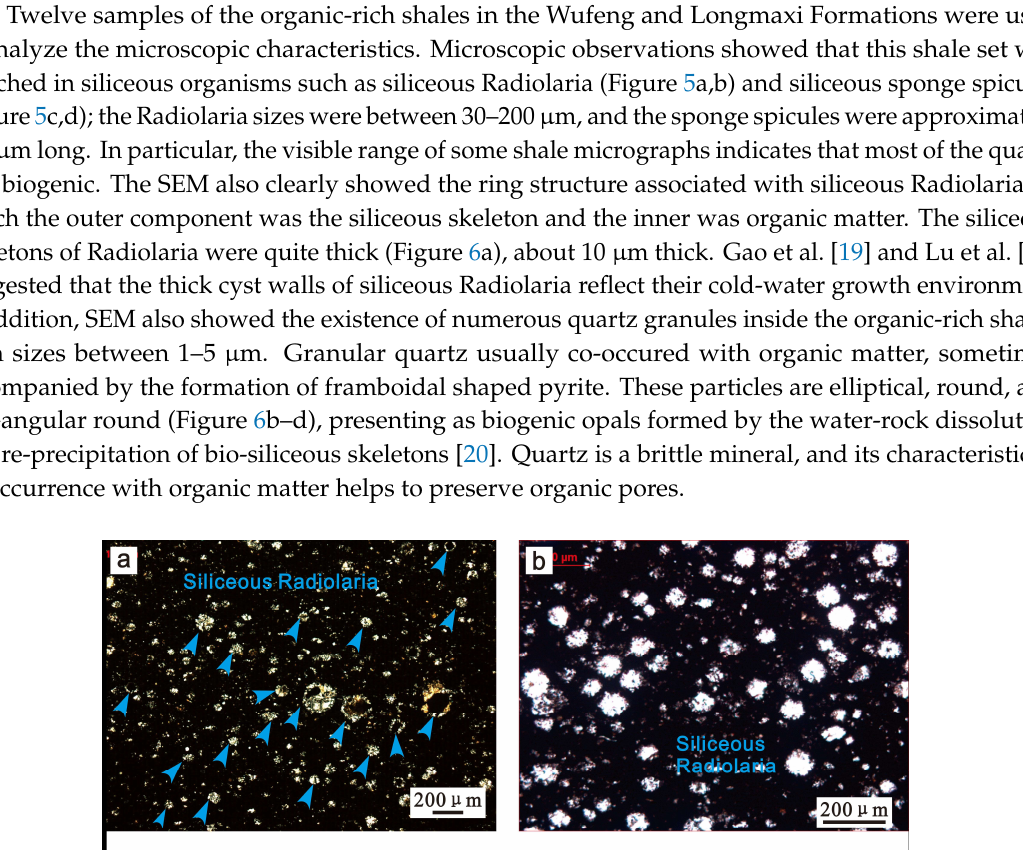
Figure 5. Characteristics of siliceous organisms of the organic-rich shales in the Wufeng and Longmaxi Formations of the Upper Yangtze region shown in thin sections. ( a,b ) Siliceous radiolaria in the organic-rich shales; ( c,d ) Siliceous sponge spicule in the organic-rich shales.